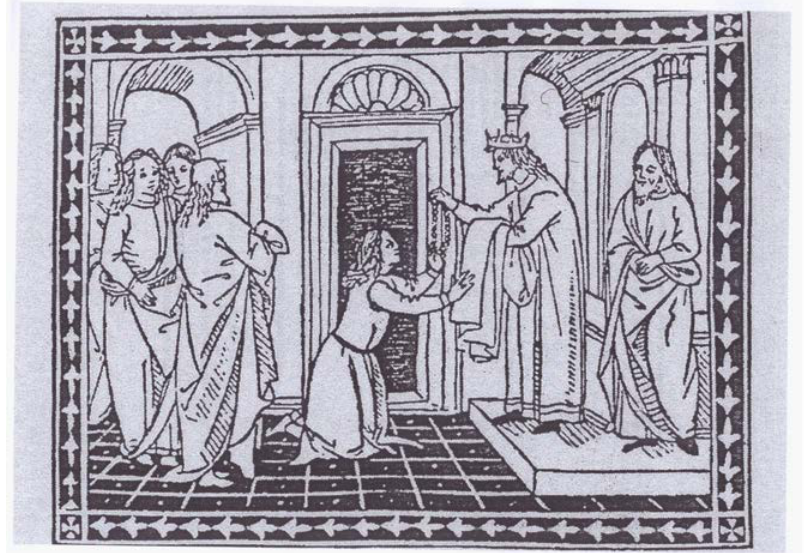
Figure 19 – Bernardo Pulci, La Rapresentatione divota di Barlaam et Iosafat , s.n.t. [but Firenze, Miscomini, around 1495], f. a7v (BNCF, Banco Rari 189.e). By permission of Ministero per i beni e le attività culturali / Biblioteca Nazionale Centrale.